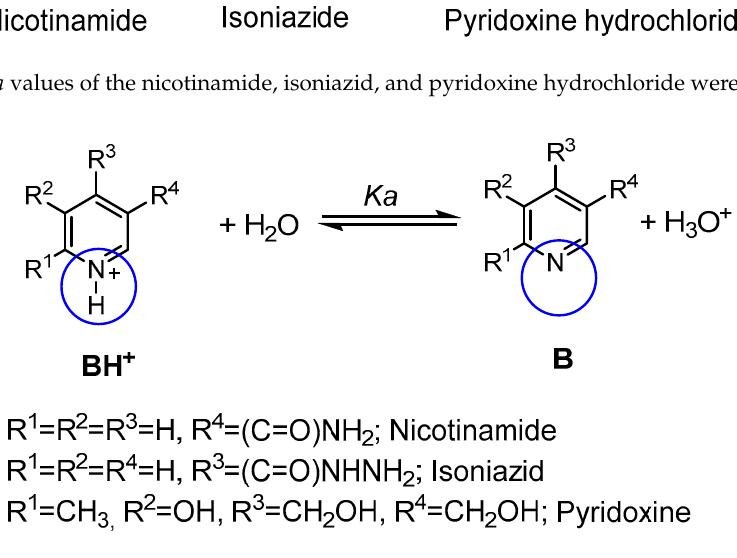
Figure 2. Protonation changes of the drugs in water.